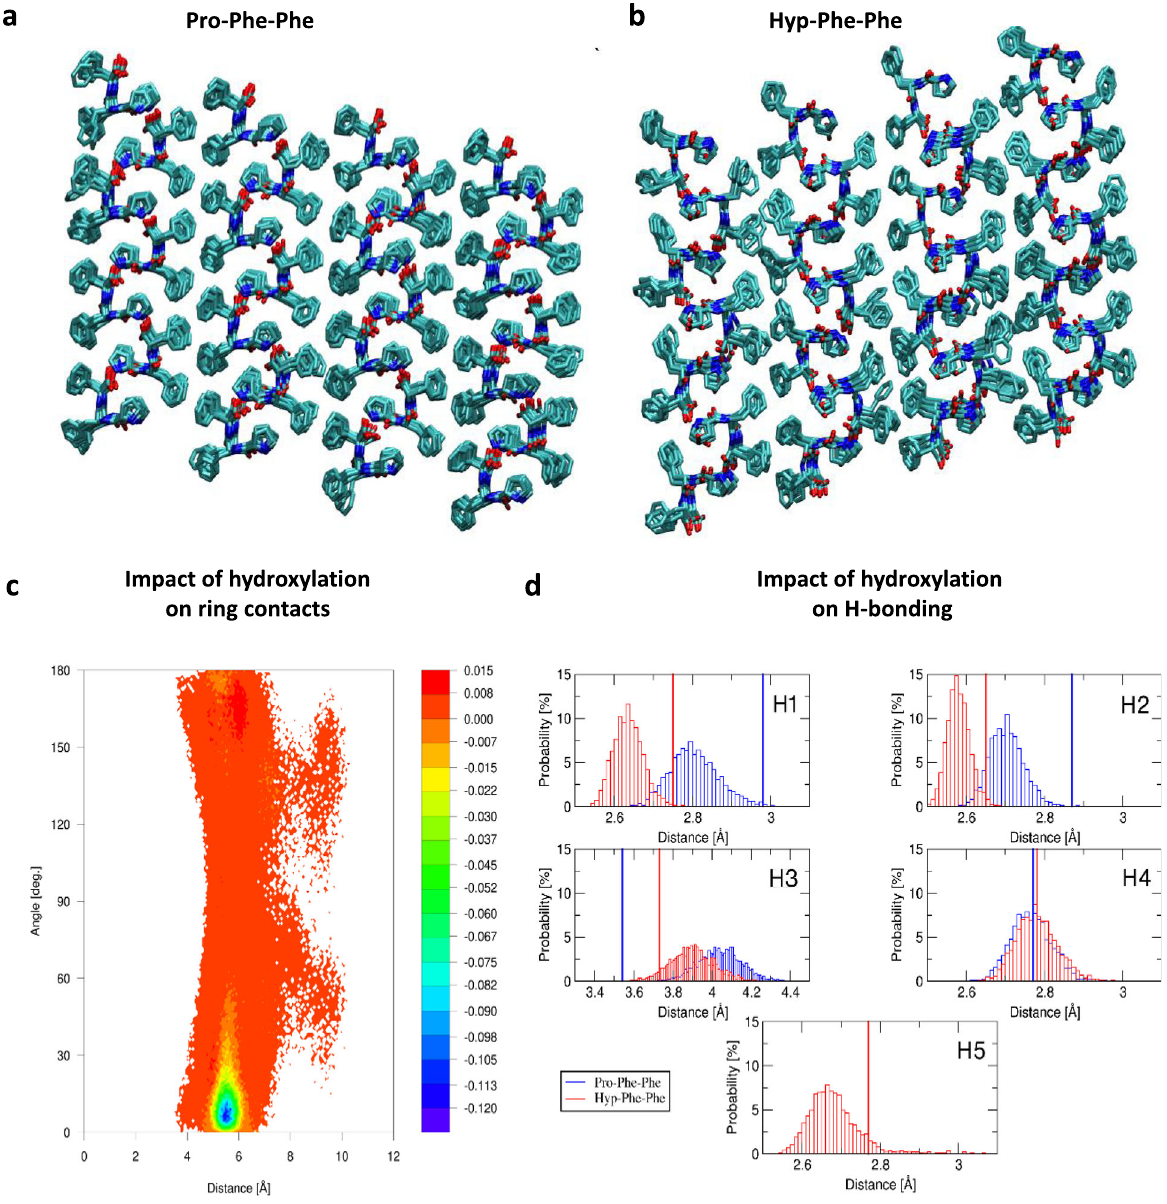
Fig. 3 Molecular dynamics (MD) simulations of Pro-Phe-Phe and Hyp-Phe-Phe assemblies. a , b The computed supramolecular packing structure in the assemblies after 0.1 µ s of room temperature dynamics of Pro-Phe-Phe ( a ) and Hyp-Phe-Phe ( b ). The balance between increased H-bonding and more fl exible π – π contacts is quanti fi ed in the Pro-Phe-Phe vs. Hyp-Phe-Phe difference map in c . The distance corresponds to the distance between neighbouring phenyl rings and the angle to the angle between the same two rings, as described in the ‘ Methods ’ section. The density is the normalized histogram and is given as a percentage. The 2D histogram is built with a 200 × 200 matrix. H-bond distributions are plotted in d . Additional supporting MD data are provided in Supplementary Figs. 14 – 19 and Supplementary Table